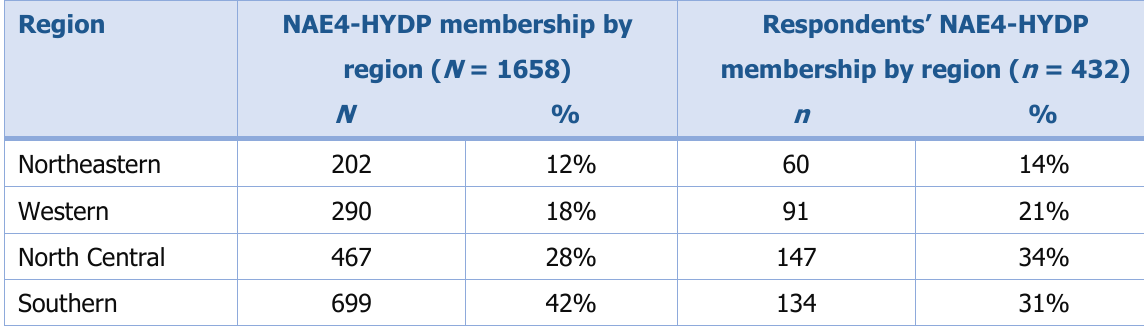
Table 2. NAE4-HYDP Regional Membership and Respondent Comparison